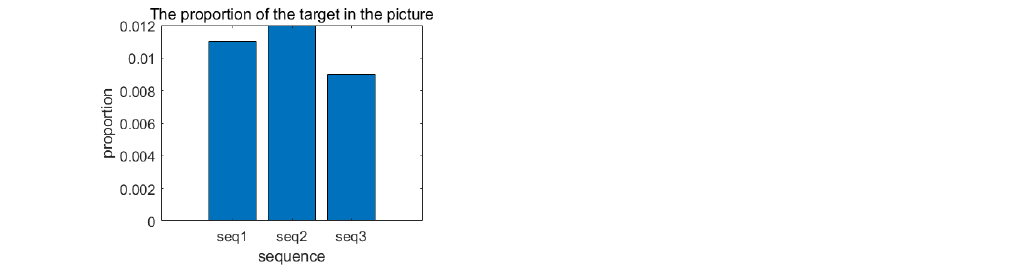
Figure 5. The area proportion of the target in the whole image for three sequences. The proportion of small targets in SSS images occupies very few pixels compared to the total